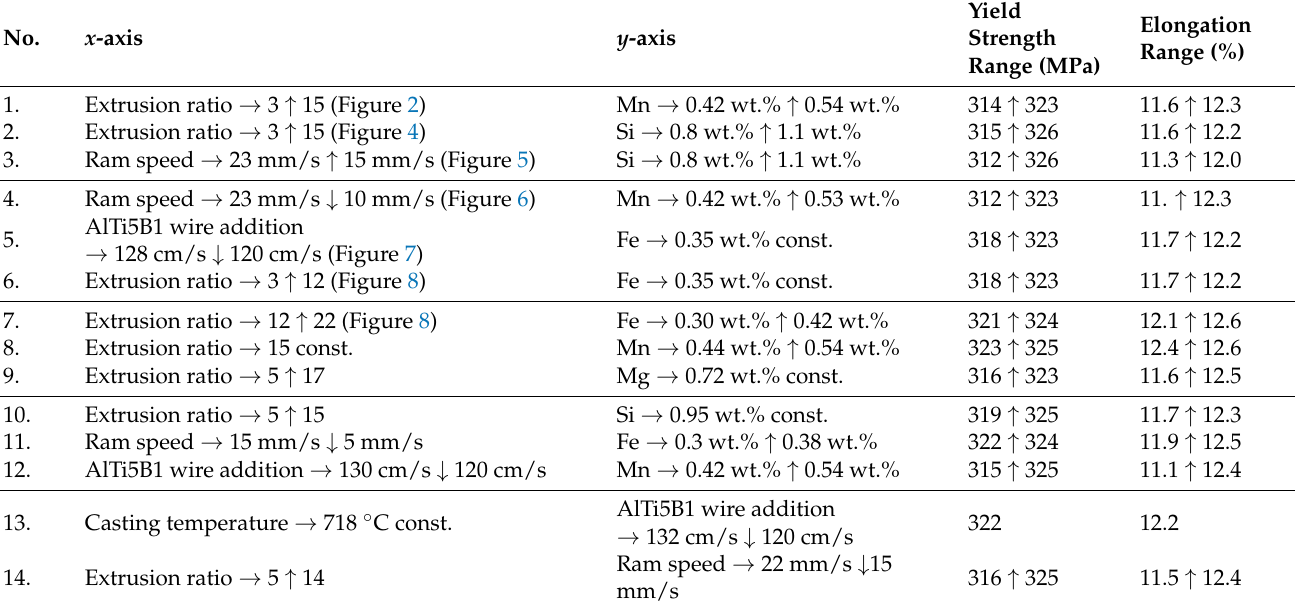
Table 6. Values for yield strength and elongation at certain content of different elements and process parameters, where both yield strength and elongation increase simultaneously. Symbols ↑ and ↓ represent increase and decrease of the property,